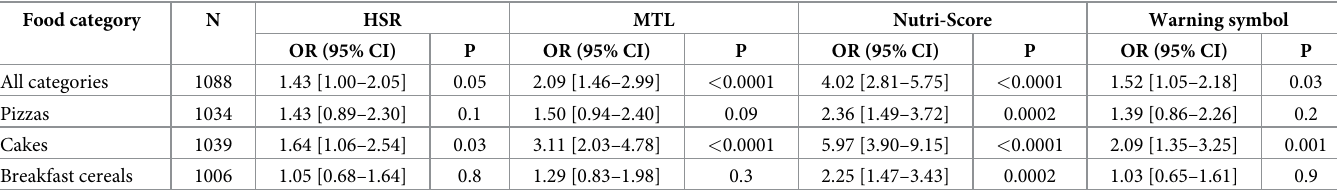
Table 3. Associations between FoPLs and the ability to correctly rank products according to nutritional quality, by FoPL and food category a (N = 1,088). Food